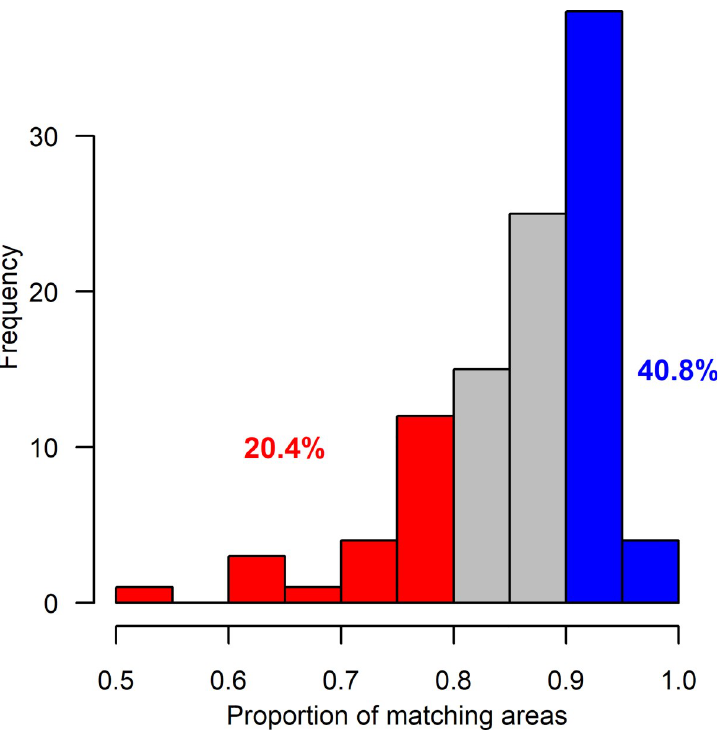
Fig 1. Histogram of the proportion of matching areas from the first part of the study. Colours are used to guide interpretation by highlighting proportions of matching areas above 90% and below 80% along with the observed relative